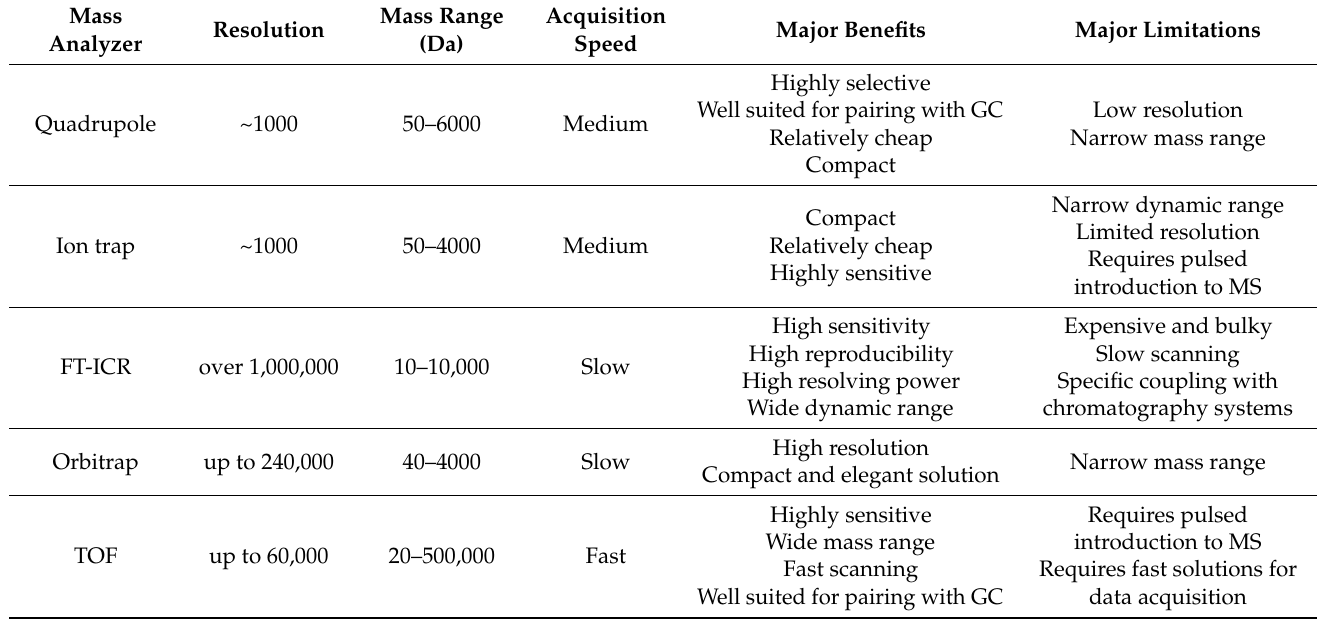
Table 2. Comparison of popular mass analyzers used in plasma and serum